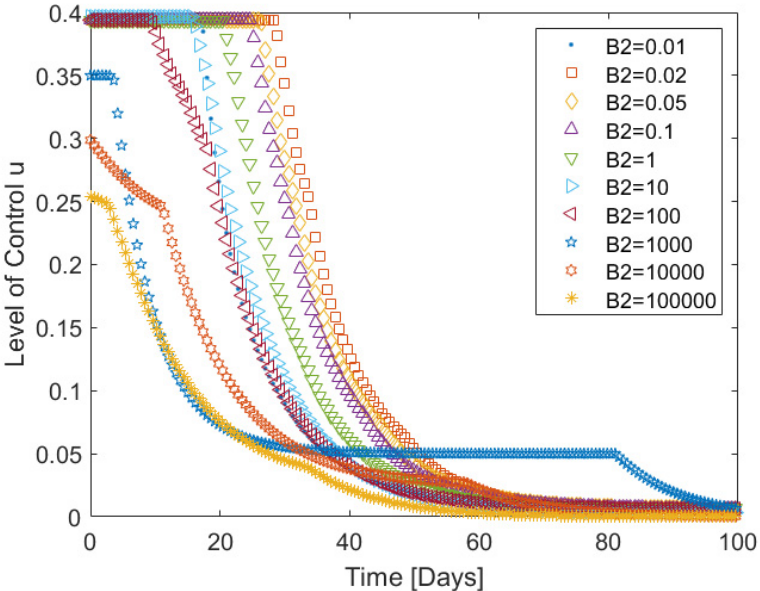
Figure 15. The time required for control signal u to stay at its maximum, t max , against the parameters of Equation (23).